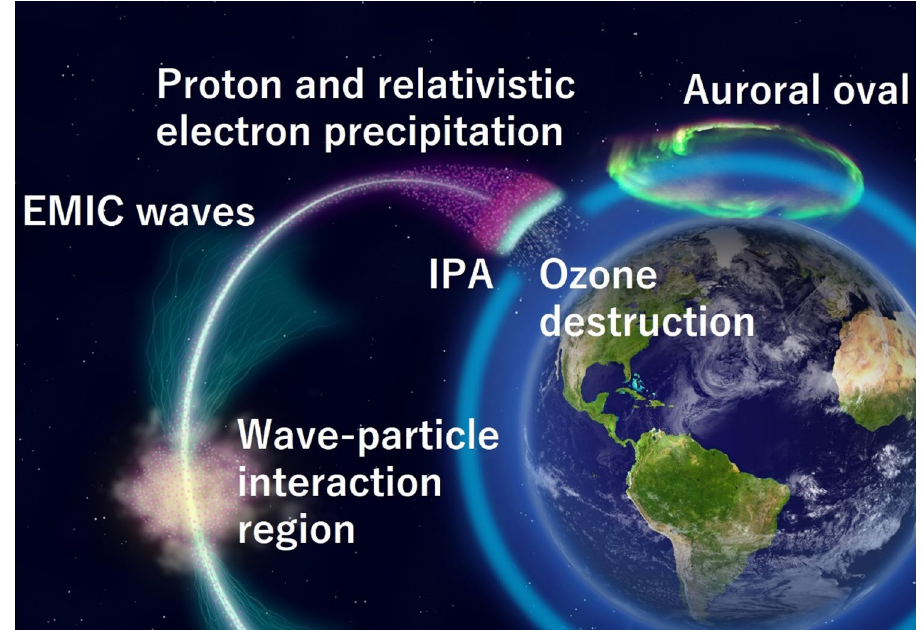
Figure 1. Effects of EMIC wave-particle interactions at different altitudes. Both EMIC-driven protons (about tens of kilo-electron-volts) and relativistic electrons precipitate into the upper atmosphere along the same geomagnetic field lines from the magnetosphere. The localized IPA optical emission due to the protons and the mesospheric ozone destruction by relativistic electron precipitation (REP) can be seen on the same field line at different altitudes. The Earth image is obtained from NASA, https:// earth obser vatory. nasa. gov/ featu res/ BlueM arble/ BlueM arble_ 2002. php. This illustration created with Adobe Illustrator version 26.2.1 (https:// www. adobe.